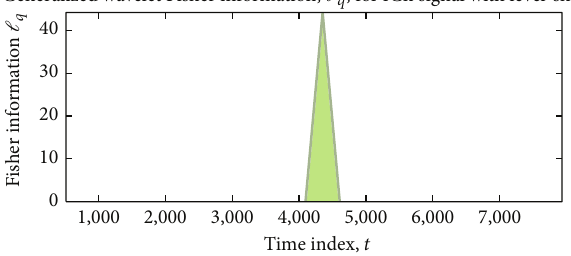
Figure 5: Level shift detection of generalized Wavelet Fisher infor- mation, J 𝑞 . The fGn signal is of length 𝑁 = 8192 , 𝐻 = 0.6 , and is analyzed in windows of 𝑊 = 512 , Δ = 256 . Note that the level = 4096 is captured by the impulse of Fisher shift located in 𝜏 ls